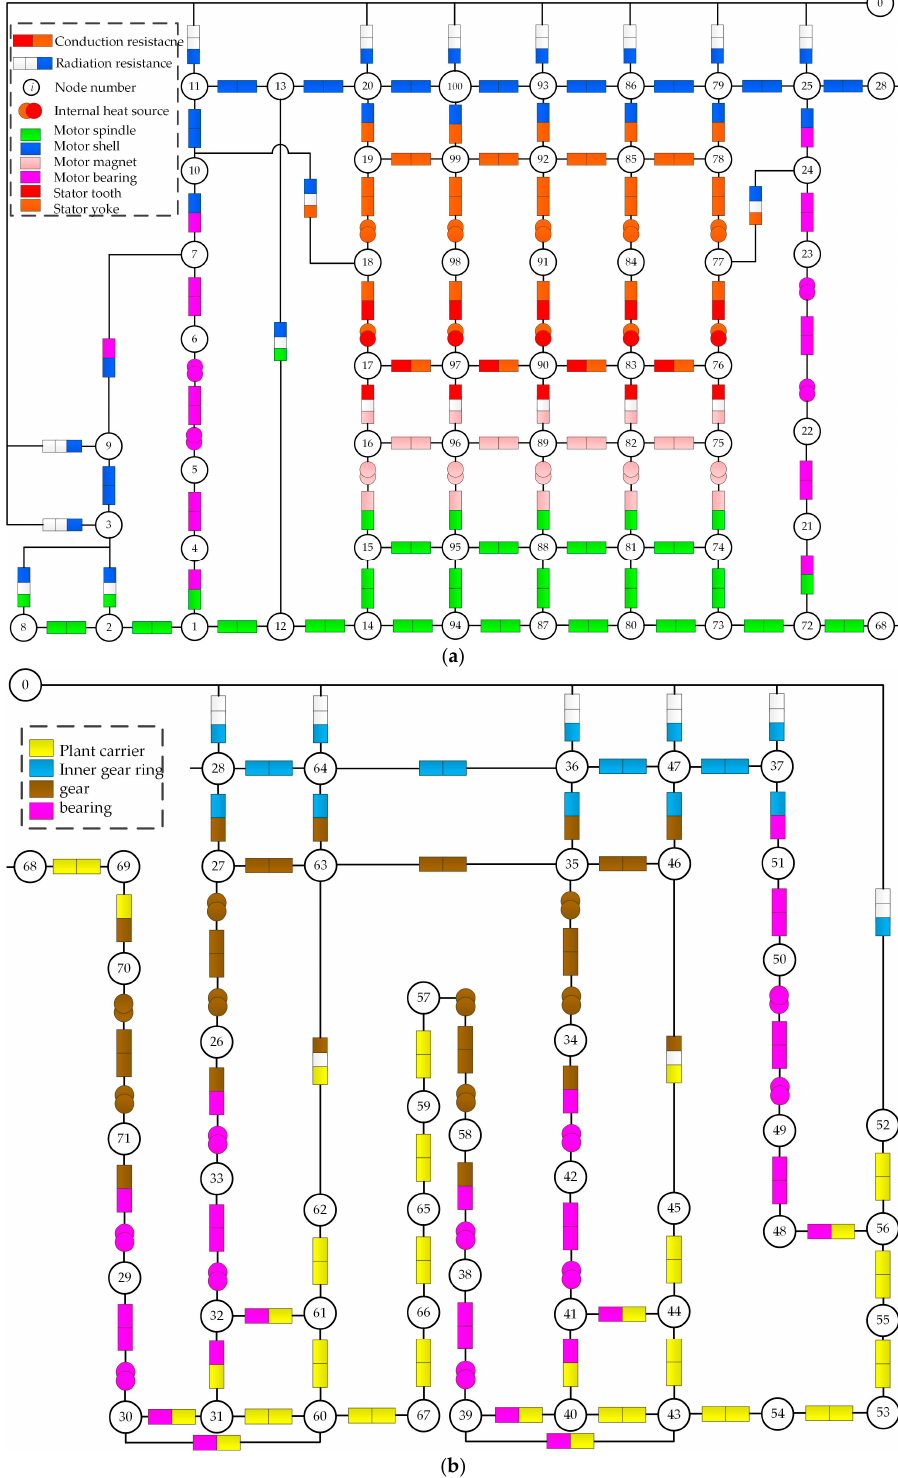
Figure 3. Thermal model of the driving component: ( a ) the thermal model of the motor and; ( b ) the thermal model of the